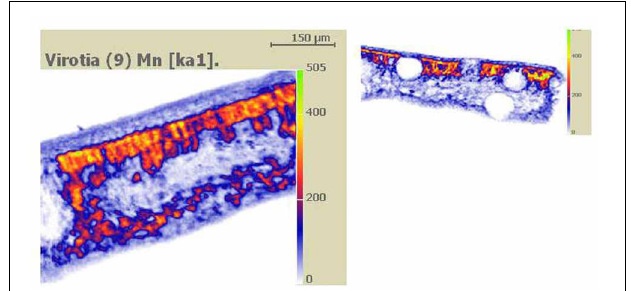
FIGURE 1 | Dry specimen preparation. Figure taken from Fernando et al. (2006a). Qualitative PIXE X-ray Mn maps of carbon-coated hand-cut leaf cross-sectional surfaces of cryo-fixed and freeze-dried Virotia neurophylla (LHS) and Gossia bidwillii (RHS) samples. High Mn deposition is represented as orange to yellow